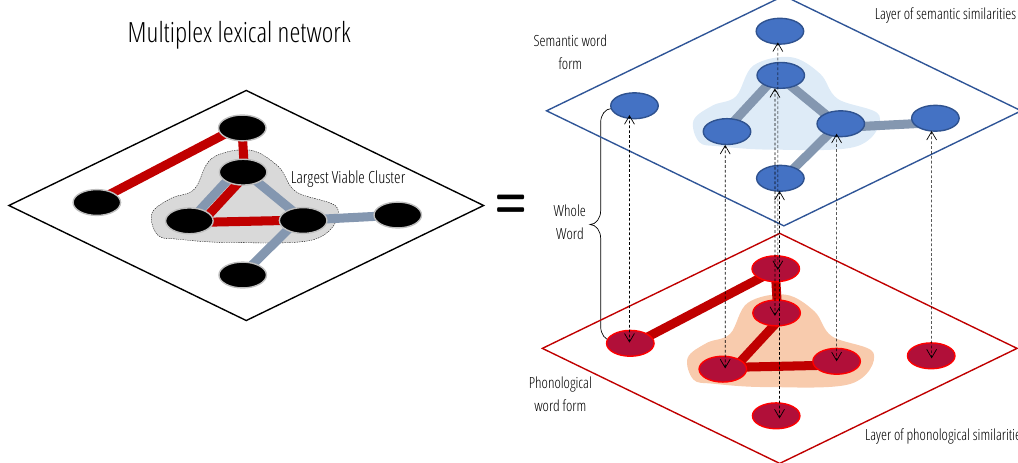
Figure 1. Example of a multiplex lexical network. Nodes represent words and can be either connected by semantic or phonological associations. ( Left ): Compact representation of a multiplex lexical network as an edge-colored graph. The largest viable cluster (LVC) is highlighted in gray. A cluster is viable if all its nodes are connected by links of a colors for all colors. Nodes in the periphery can be accessed only by using red (gray) links and therefore do not belong to the LVC. ( Right ): Multilayer representation of a multiplex lexical network. As in psycholinguistics, each word has a semantic representation and a phonological one. Semantic word forms can be connected if they are synonyms, hypernyms/hyponyms or free associations. Phonological word forms can be connected if they differ for the addition/substitution/deletion of 1 phoneme. Semantic (phonological) links give rise to a network layer of semantic (phonological) similarities. Notice that the left and right visualizations are equivalent as in our model there is no transition cost between network